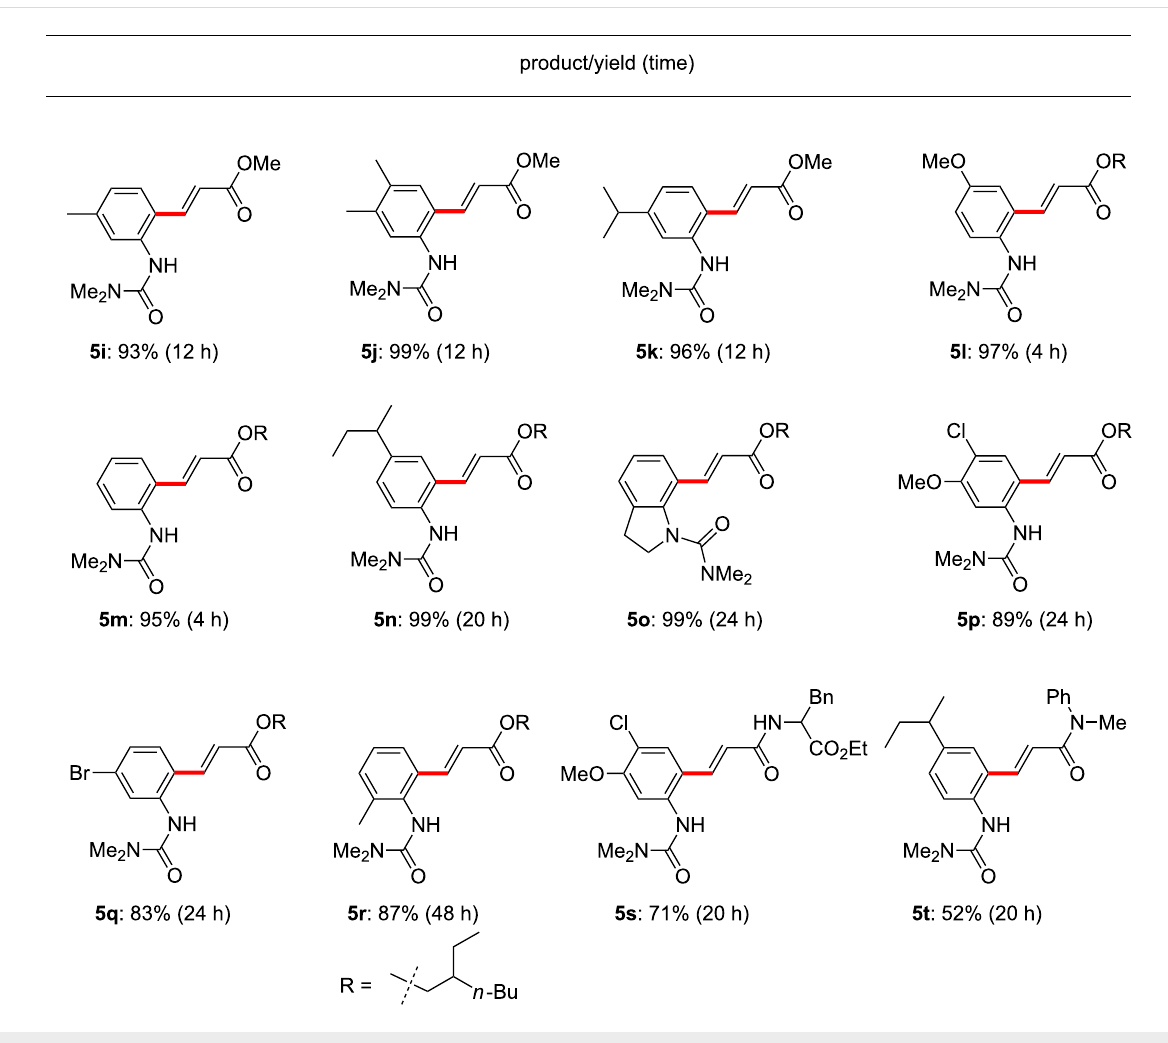
chose to synthesize boscalid ® , a pesticide currently prepared on a yearly kiloton scale by means of a traditional Suzuki–Miyaura coupling. It is used to control a range of plant pathogens in broadacre and horticultural crops (Scheme 6) [207]. Felpin